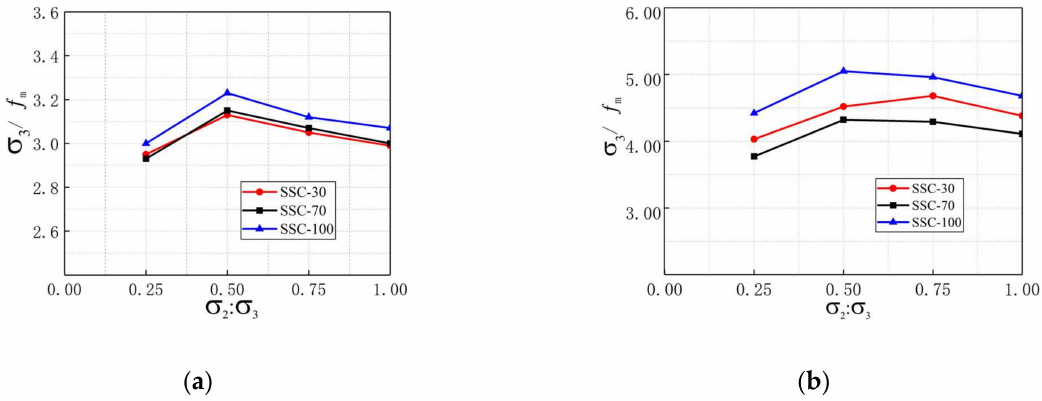
Figure 5. Influence of stress ratio on σ 3 / f m : ( a ) σ 1 : σ 3 = 0.05:1; ( b ) σ 1 : σ 3 = 0.1:1.